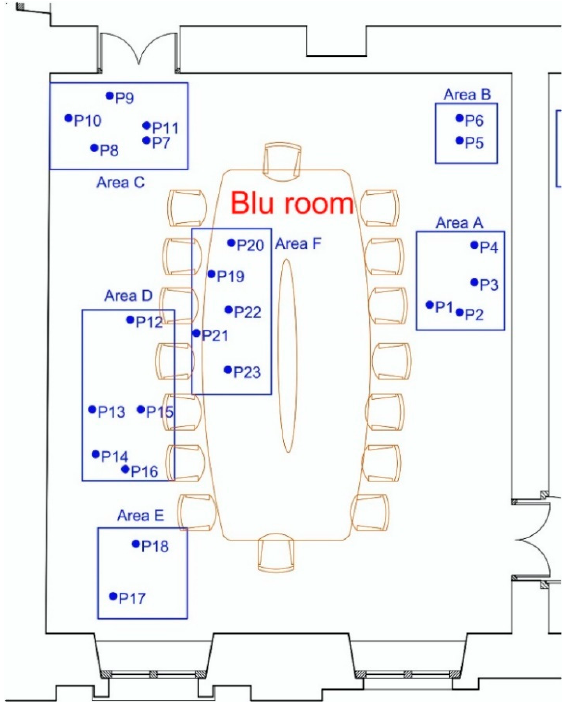
Figure 10. Map of the points and areas tested on the vault of the Blu room.